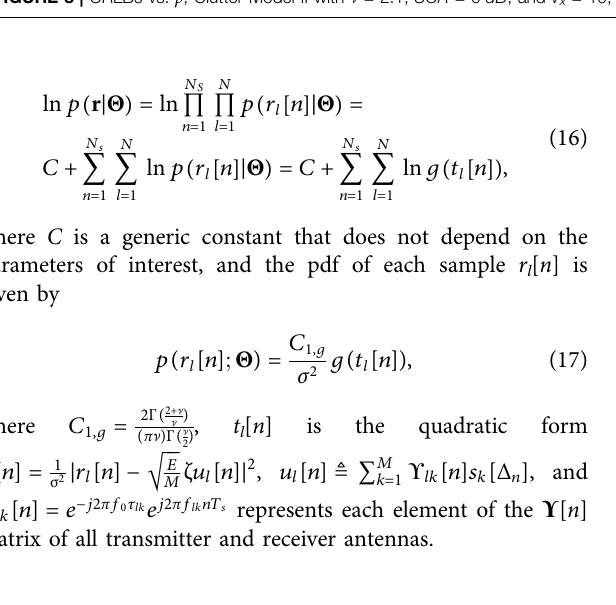
Frontiers in Signal Processing |